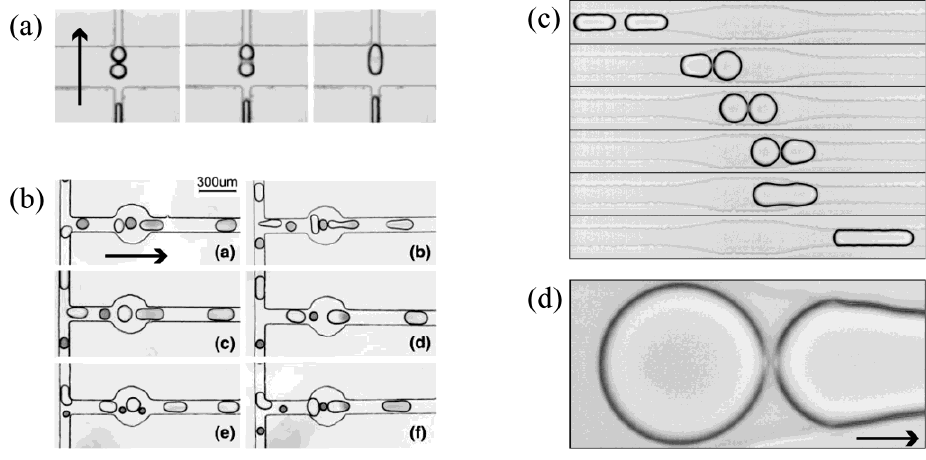
Figure 11. Passive droplet merging realized by design of the channel geometry. ( a ) and ( b ) show the merging of two or more droplets. Reprinted from [91,92] with permission from Springer; ( c ) and ( d ) demonstrate last moment of droplet merging, called decompression merging. Reprinted from [93] with permission from the American Physical Society (APS). Note: the arrows indicate the traveling direction of the